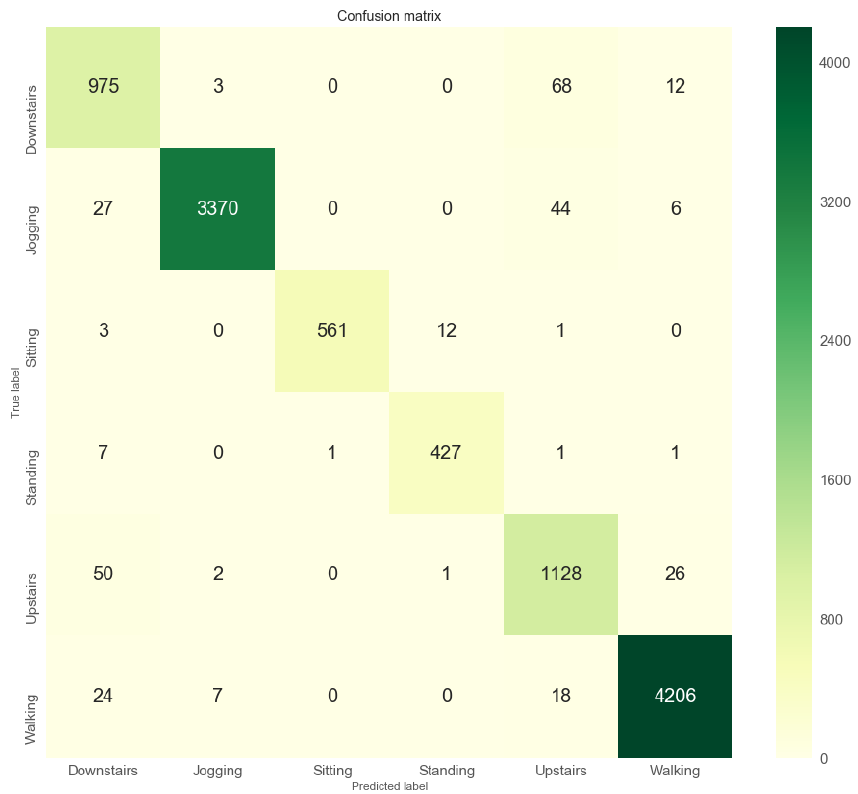
Figure 5. The results for a classifier of the LSTM